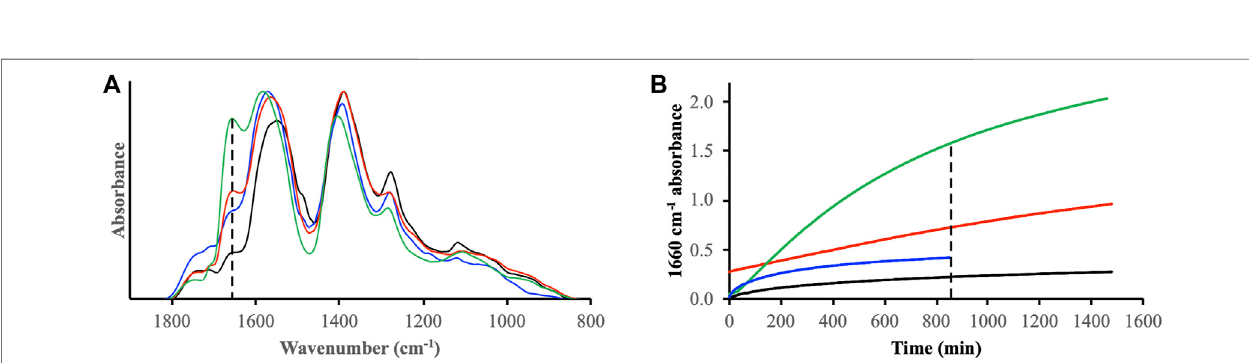
FIGURE 7 | The 1,660 cm − 1 band intensity as a function of time (blue lines) during the reaction between 100 μ M H 2 O 2 and pre-equilibrated (24 h) DOM mod-EtOAc - ferrihydrite (A) and DOM mod-H2O -ferrihydrite (B) suspensions. These experiments were performed at TOC 12 of μ mol m − 2 and pH 4.0. The hTPA generated by the reaction between H 2 O 2 and ferrihydrite in absence of DOM are shown on the right-hand y-axis as red diamonds.